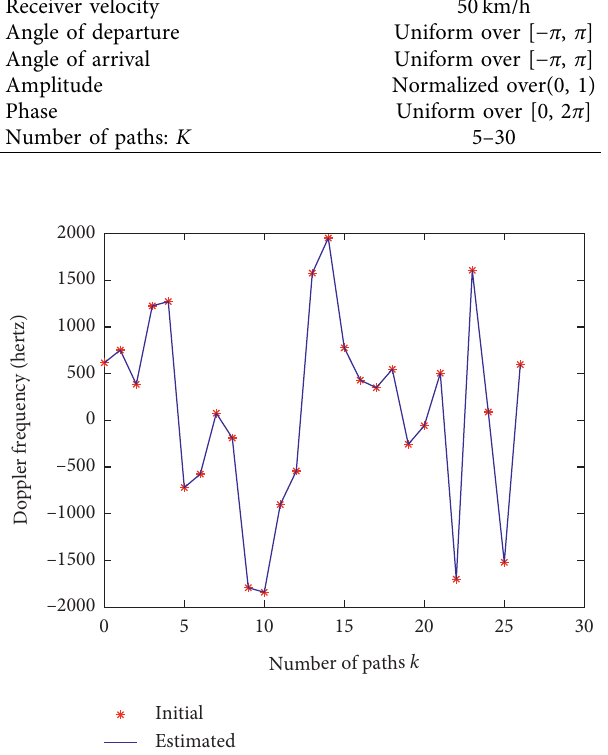
Figure 4: Doppler frequencies for 3D-3GPP and estimated